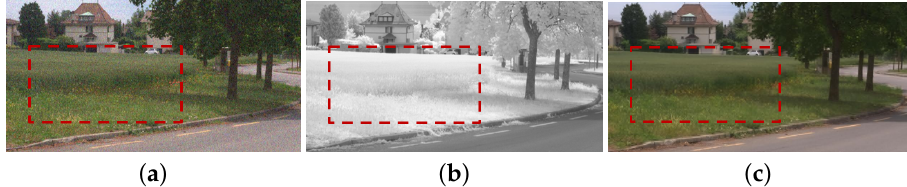
Figure 21. Experimental results on test paired images with weak structure in the NIR images. ( a ) RGB image; ( b ) NIR image; ( c ) Fusion